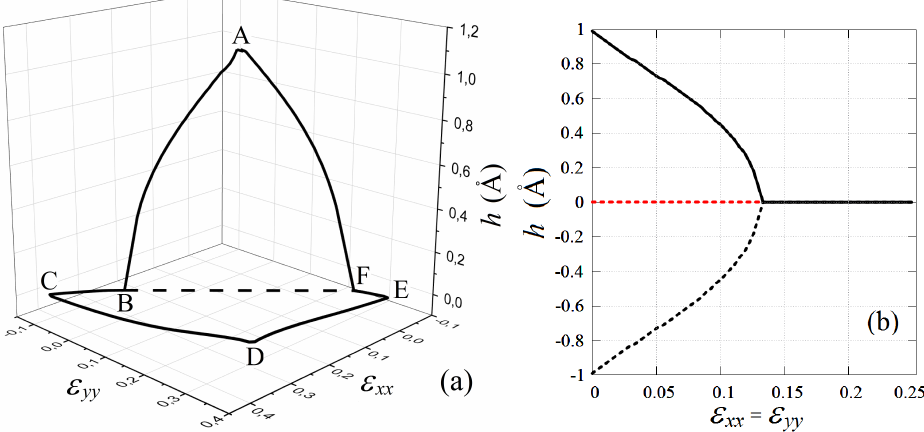
Figure 5. ( a ) Stanene height change in the planar stanene stability region. In the ABFA region, stanene is buckled ( h > 0), and in the CDEC region, it is absolutely flat ( h = 0); ( b ) bifurcation diagram showing a possible change in the height of the stanen along the line ε xx = ε yy